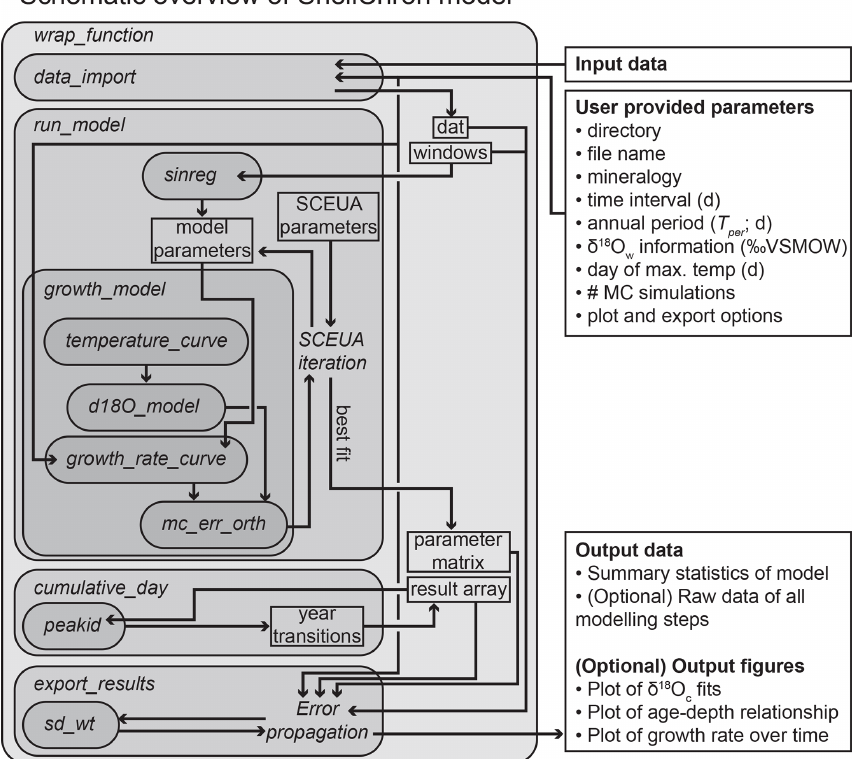
Figure 1. Schematic overview of ShellChron. Names in italics refer to functions (encapsulated in rounded rectangular boxes) and operations within functions. Rectangular boxes represent data. Arrows represent the flow of information between model components. Note that some operations are encapsulated in functions (e.g., Error propagation in export results ) and that some functions are only used within other functions (e.g., peakid in cumulative_day ). All data structures outside wrap_function represent input and output of the model. Detailed documentation of all functions and operations in ShellChron is provided in SI1 (see also the “Code and data availability”